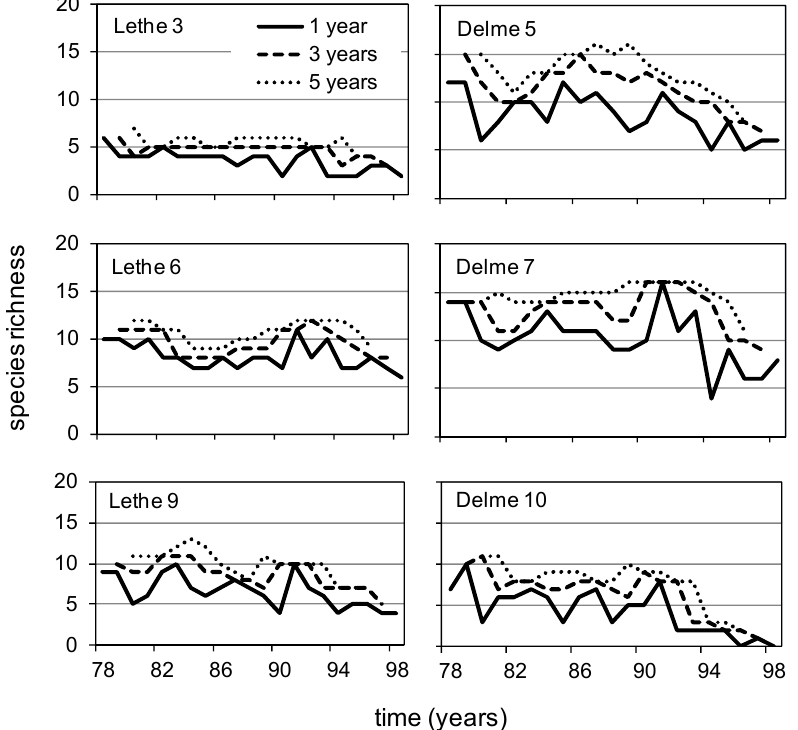
Figure 9. Cumulated hydrophyte species richness across temporal